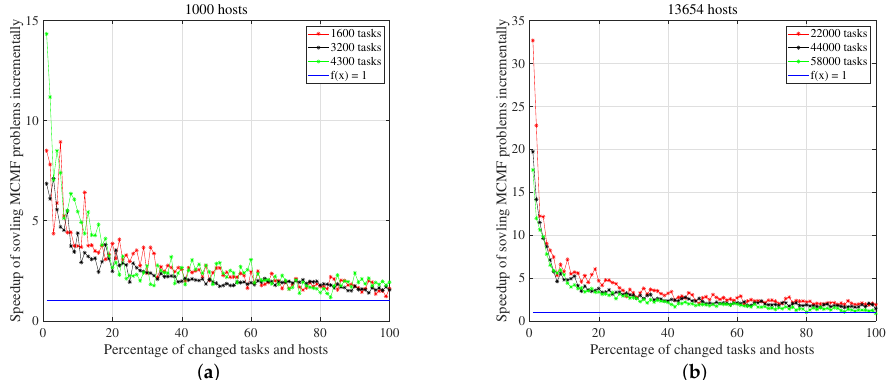
Figure 6. Speed-up of solving MCMF problems incrementally compared to solving them from draft. ( a ) 1000 hosts. ( b ) 13,654